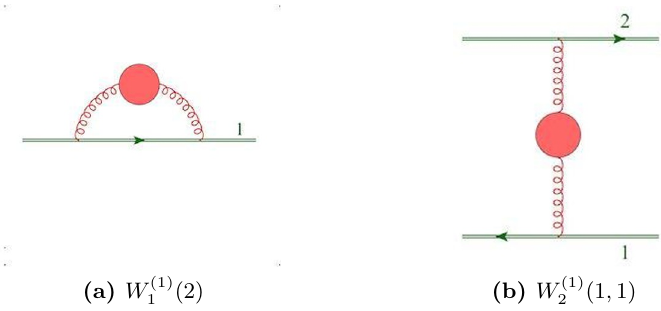
Figure 4. The only two Cwebs whose perturbative expansion starts at O ( g 2